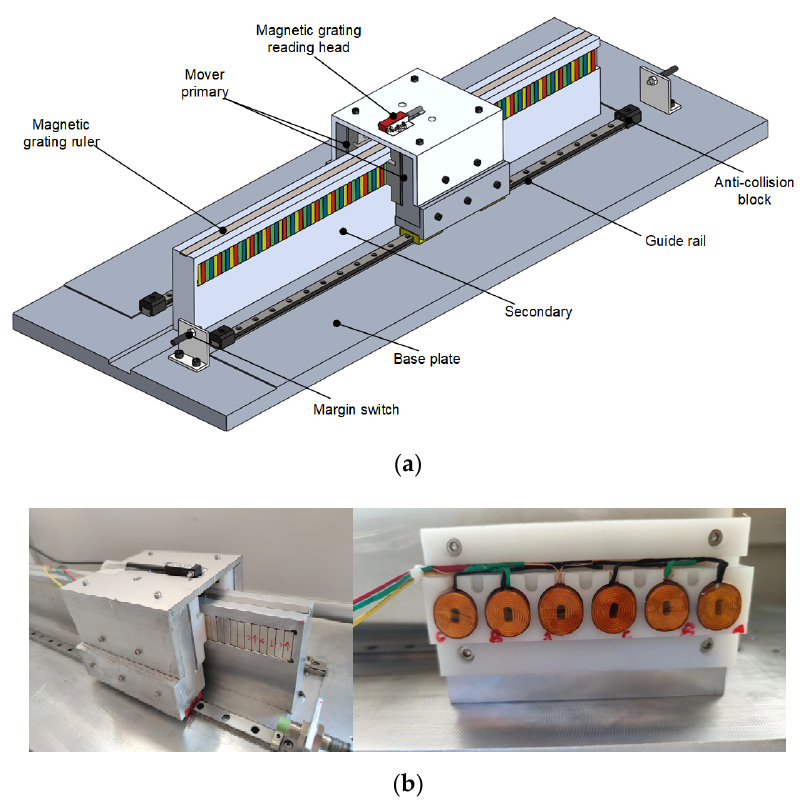
Figure 2. Structure diagram of electromagnetic actuator: ( a ) Mechanical structure; ( b ) Mover pri- mary structural.